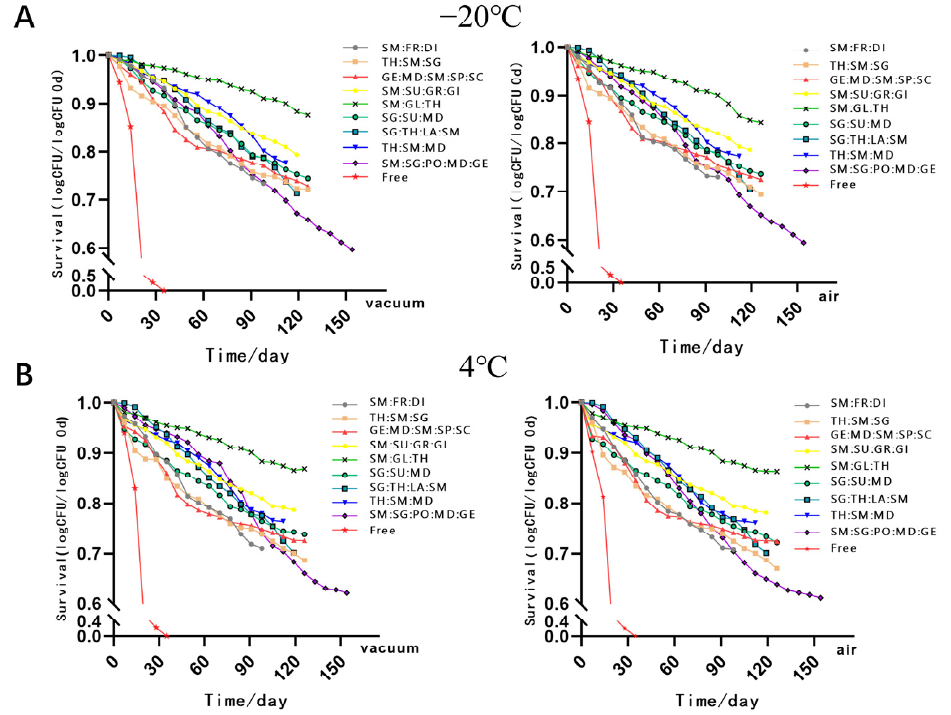
Figure 1. The number of viable cells in the microencapsulated LR-LFCA stored at − 20 °C ( A ) and 4 °C ( B ) under two different storage atmospheres: air or vacuum.